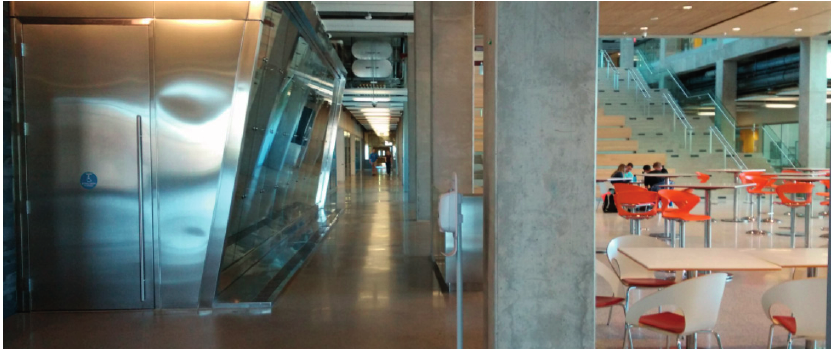
Figure 3. Indoor test environment at EEEL.